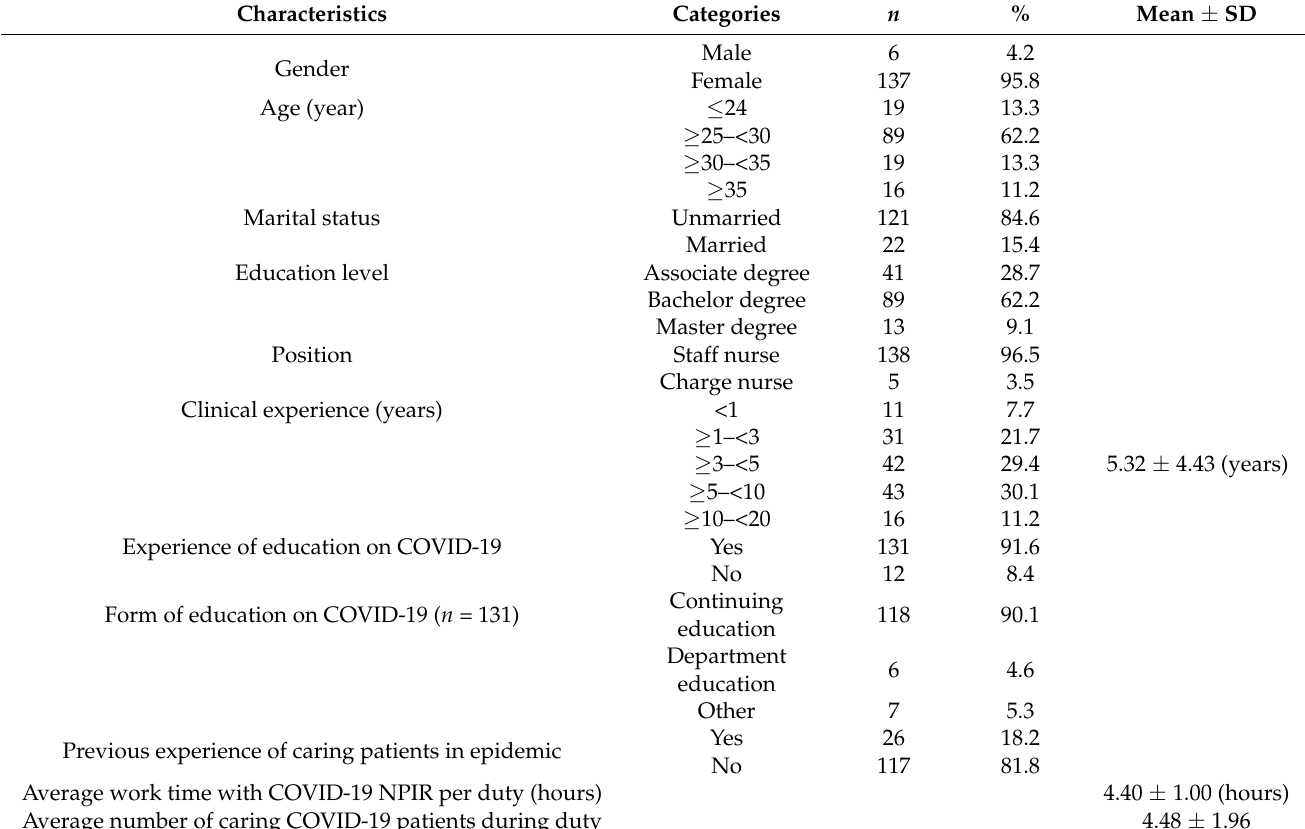
Table 1. Participants’ characteristics ( n =